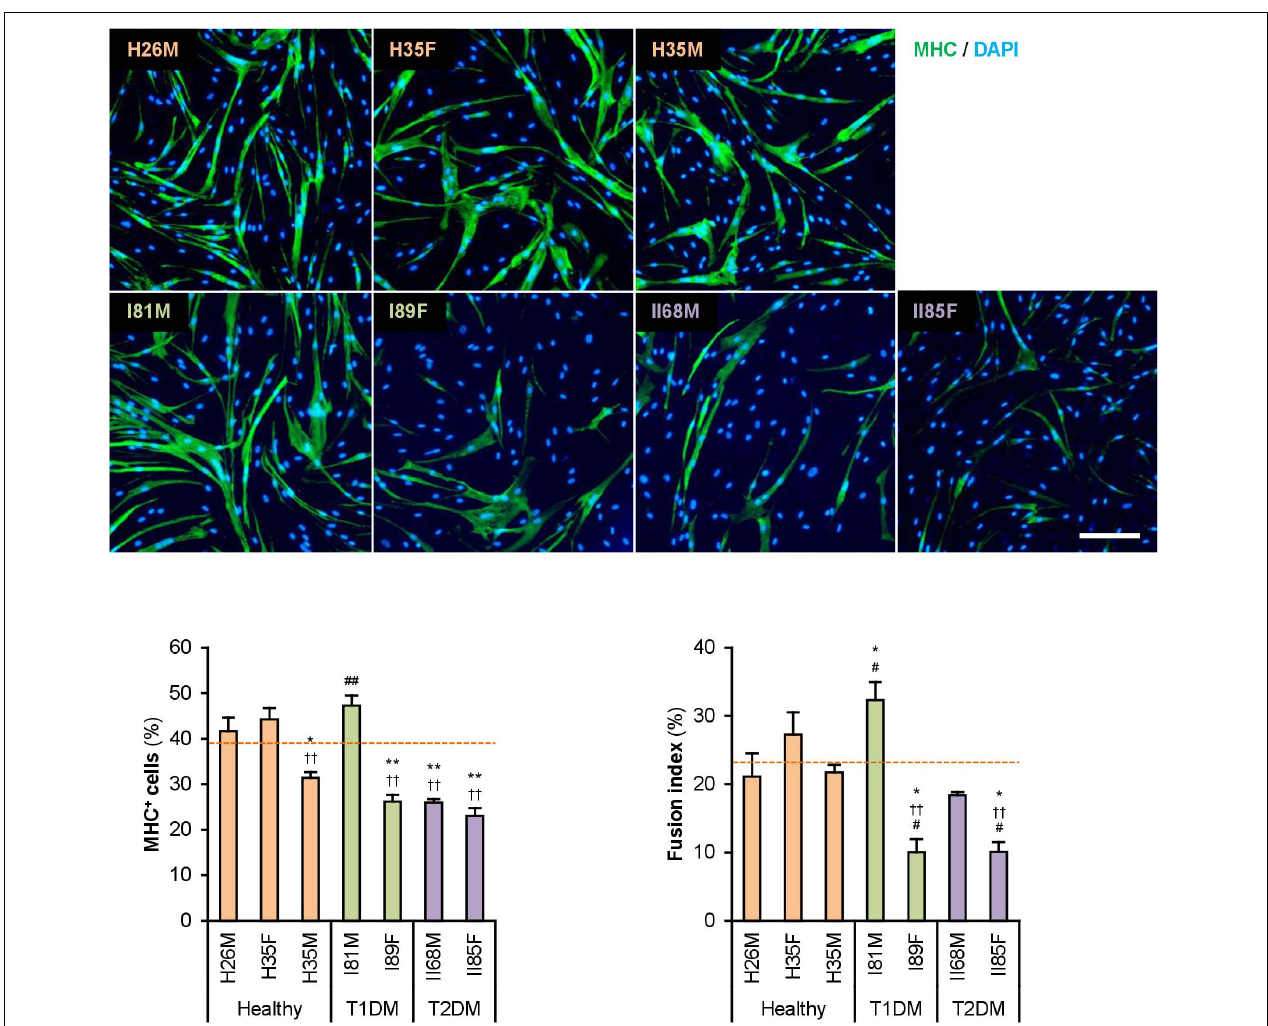
FIGURE 1 | Attenuated myogenic differentiation of DM myoblasts. Representative immunofluorescent images of the hMBs differentiated in DIM-NG for 2 days. Scale bar, 200 µ m. Ratio of MHC + cells and multinuclear myotubes were quantified. Orange dashed lines indicate the mean values of H26M, H35F, and H35M. * p < 0.05, ** p < 0.01 vs. H26M; †† p < 0.01 vs. H35F; # p < 0.05, ## p < 0.01 vs. H35M (Tukey–Kramer test); n =